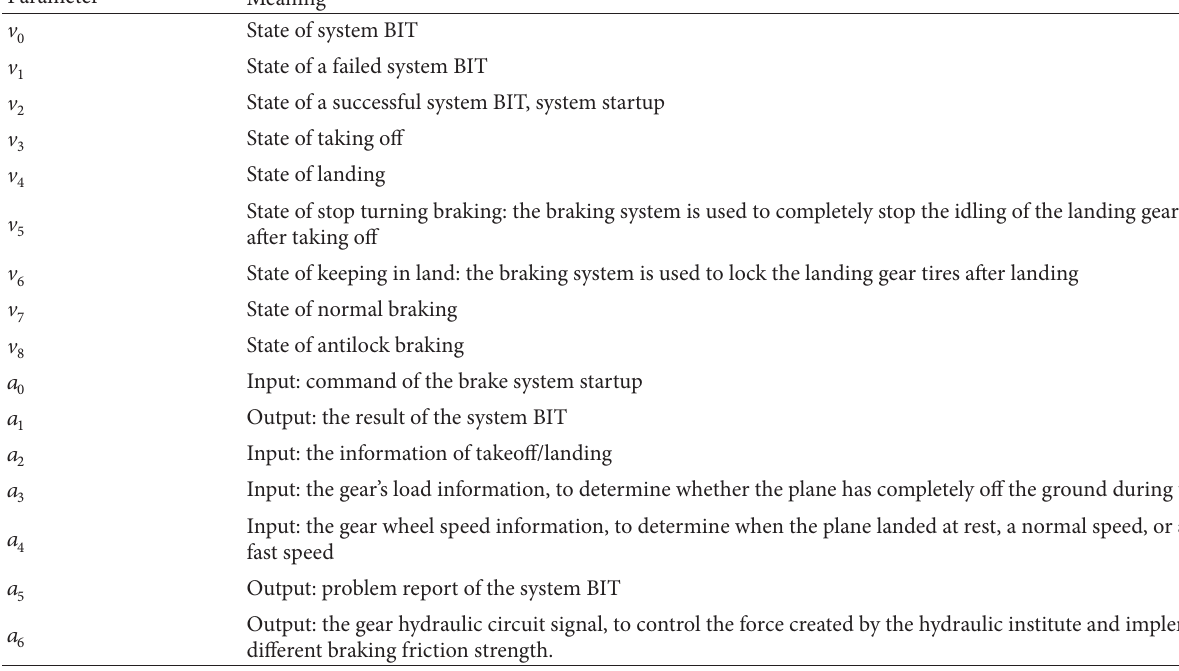
Table 1: Parameters of the aircraft braking